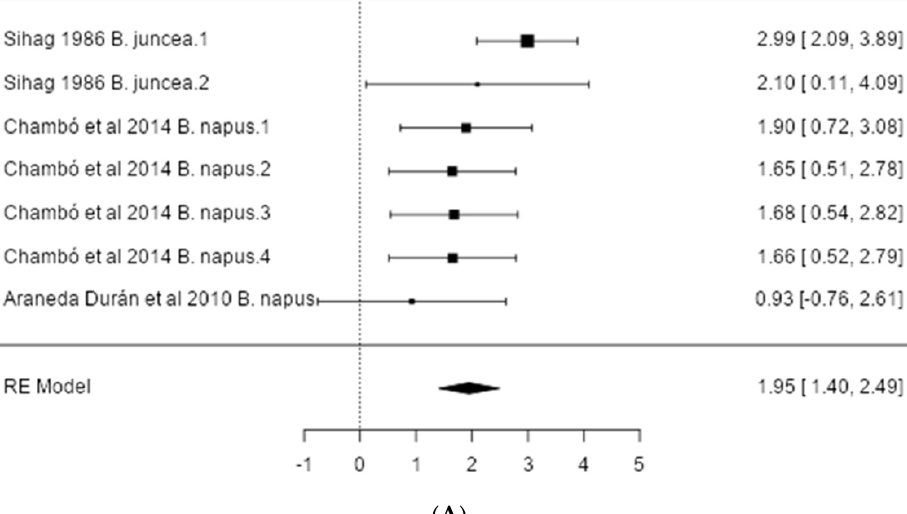
Figure 2. Percentage of publications showing an increased, decreased, and neutral effect of insect pollination on seed yield measured as seed weight/(plant, area, or open flower) (Y); weight of seeds (1, 100, or 1000 seeds) (WS); silique set (SQS); number of siliquae/(plant or area) (NSQ); number of seeds/(silique or open flower) (NSSQ); silique length (SQL); number of seeds/(area, plant, or branch) (NSP); seed germination (G), and oil content (O). An increased, decreased, or neutral effect is shown in red, blue, or green, respectively, in self-compatible ( A ) and self-incompatible Brassicaceae crops ( B ).